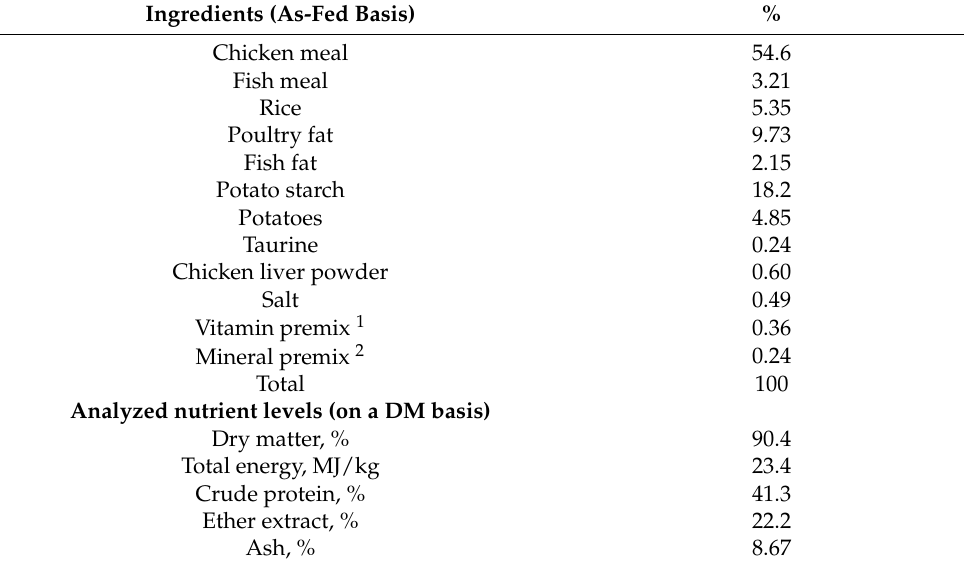
Table 1. Ingredients and nutrient levels of basal